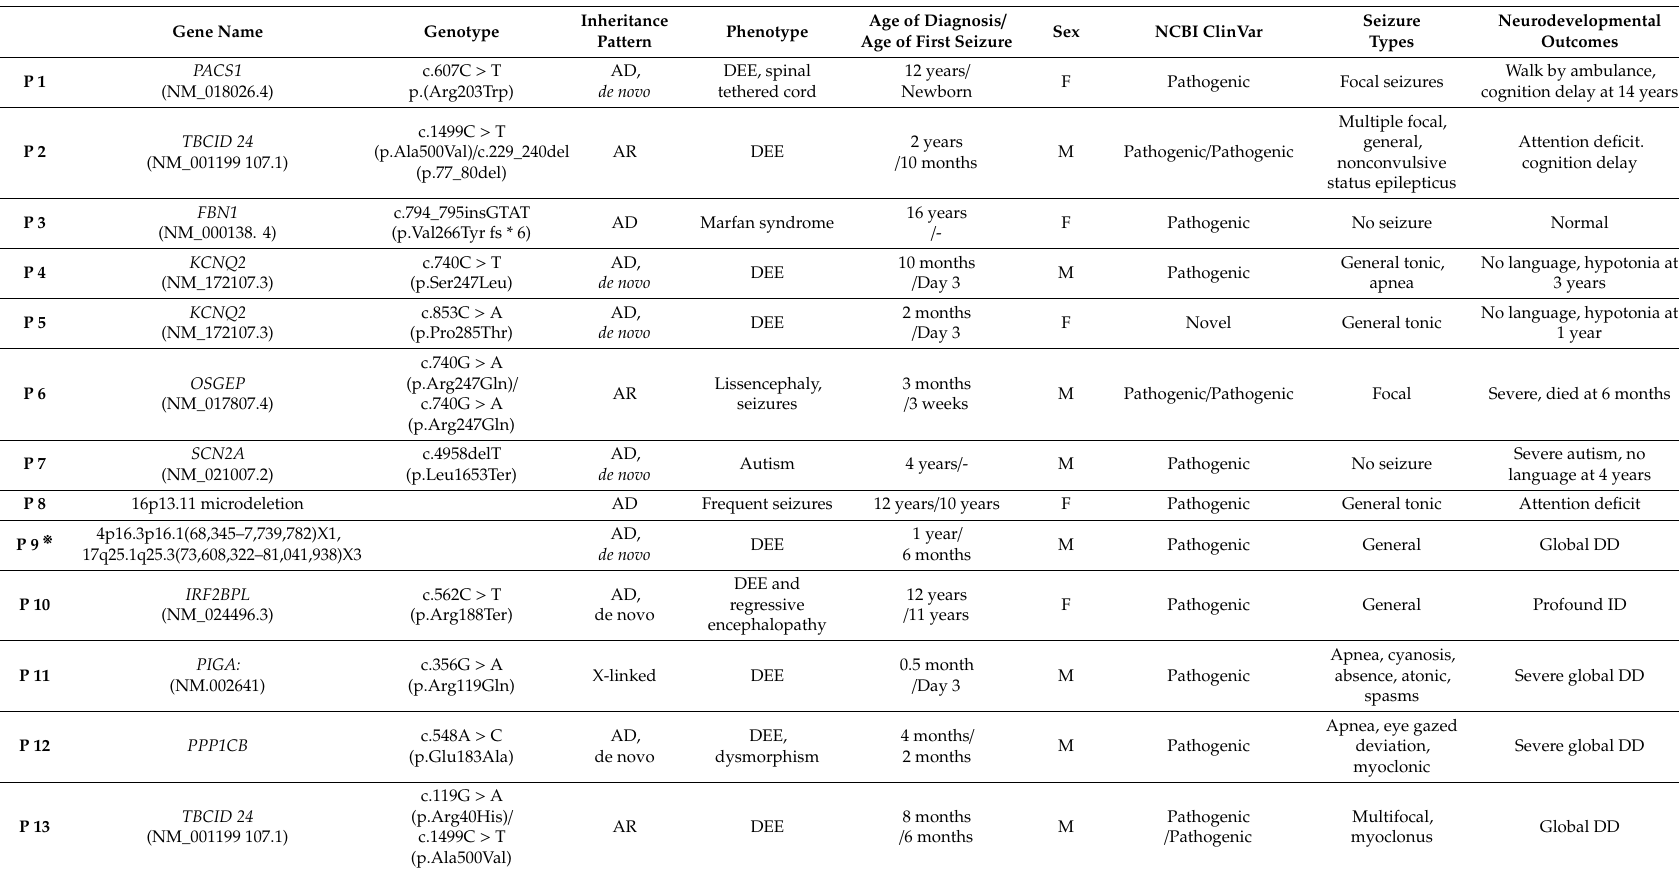
Table 2. The genetic and clinical features are summarized in those patients with identified mutations by